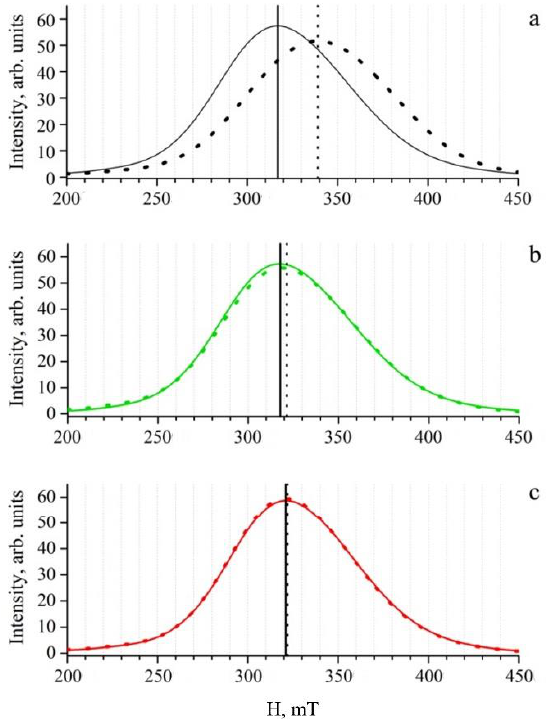
Figure 3. Electron magnetic resonance (EMR) absorption curves of the diluted samples “N0” ( a ), “NH0” ( b ), “NH1” ( c ) before (all solid lines) and after (all dotted lines) the addition of immunoglobulin G. Immunoglobulin G was added after the overnight incubation of samples. The IONP concentration in all of the analyzed samples was 0.05 mg/mL. The resonance field of the corresponding spectra before and after the addition of IgG are marked in the figure. Table 1. Experimental g-factors of the EMR signals of IONPs in samples with and without immu- noglobulin G (IgG).